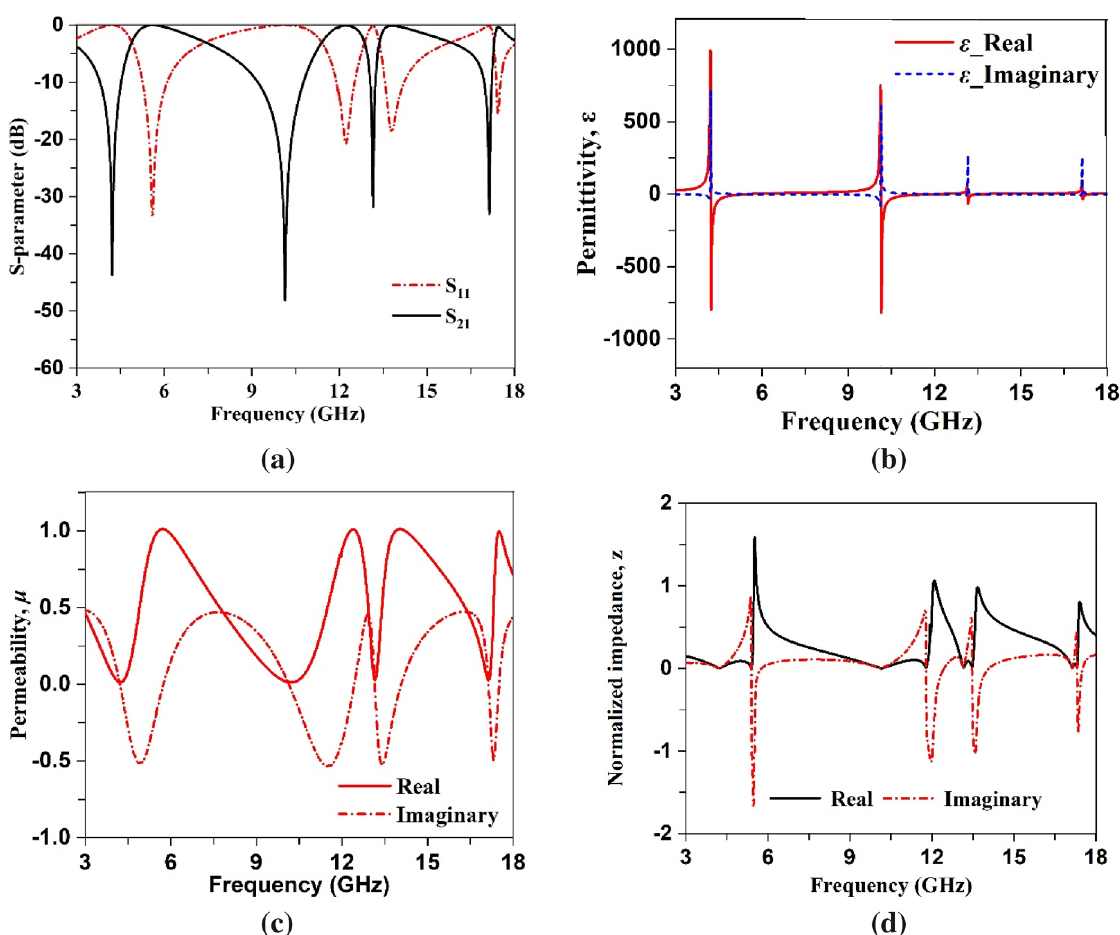
Figure 10. ( a ) Scattering parameters plot ( b ) permittivity ( c ) and permeability plot ( d ) normalized impedance